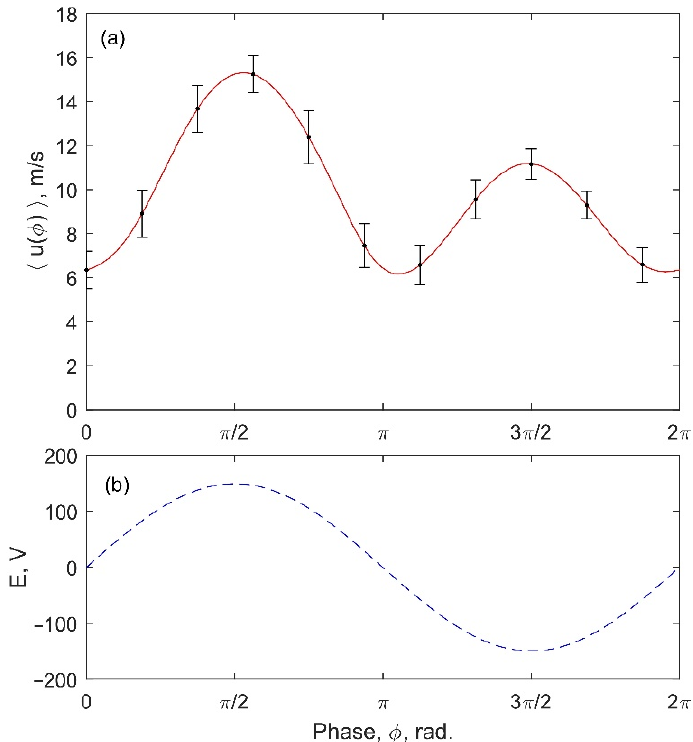
Figure 3. ( a ) Phase-averaged jet velocity, (cid:104) u( φ ) (cid:105) , at the exit of the orifice Y/D = 0 in response to Figure 3. ( a ) Phase ‐ averaged jet velocity, 〈 u( ϕ ) 〉 , at the exit of the orifice Y/D = 0 in response to ( b ) ( b ) the sinusoidal excitation at the frequency of fe = 1220 Hz and the excitation voltage of E = 150 Vpp. the sinusoidal excitation at the frequency of fe = 1220 Hz and the excitation voltage of E = 150 Vpp. Error bars mark the standard deviation in estimating the phase-averaged jet Error bars mark the standard deviation in estimating the phase ‐ averaged jet velocity.